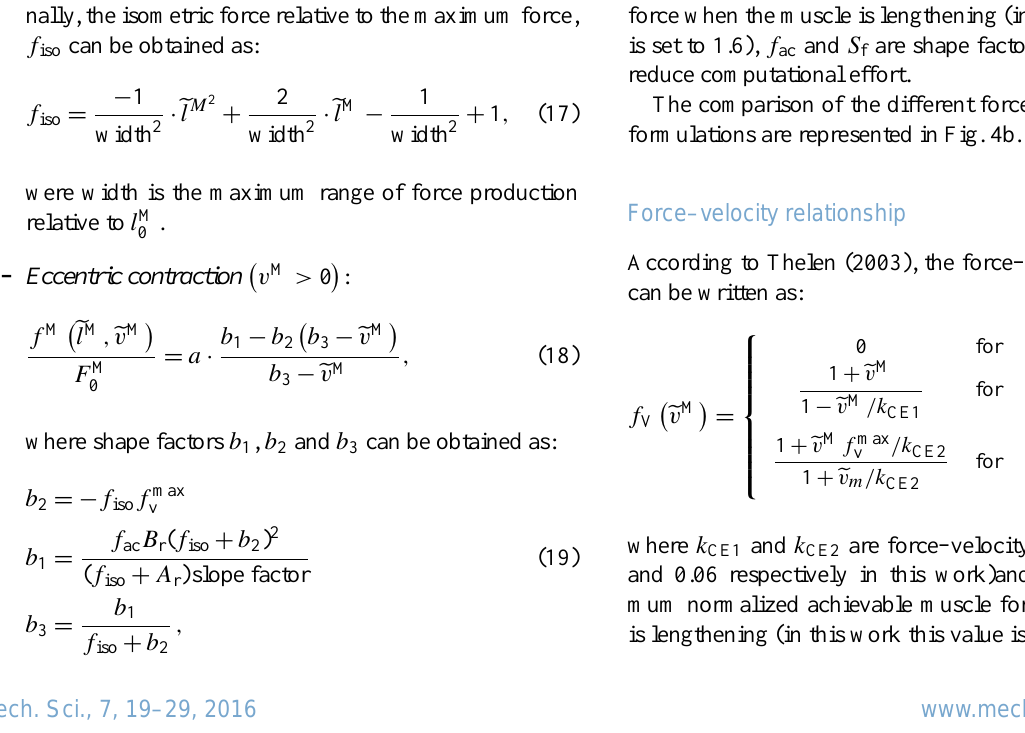
those constants are set to A r = 0 . 41 and B r = 5 . 2.